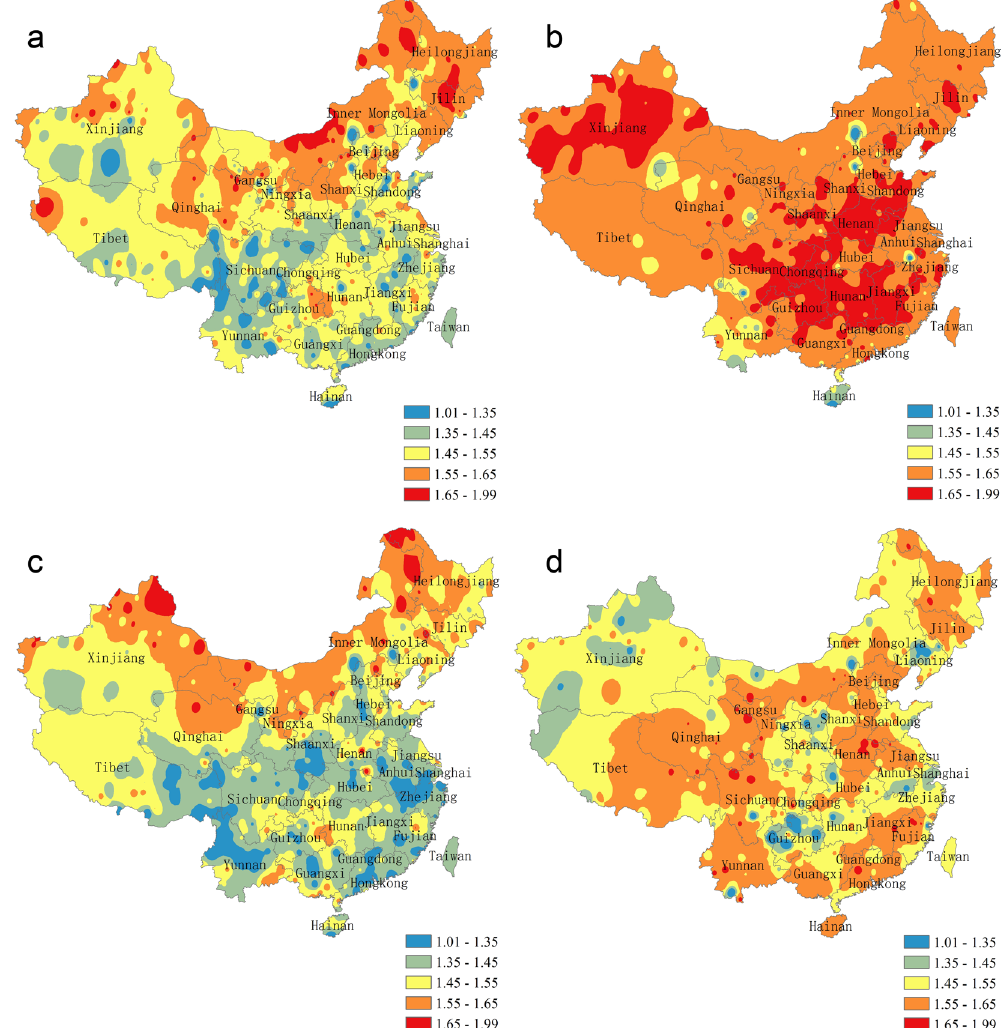
Figure 2. Variability of four climatic factors dynamics in China from 1960 to 2013: ( a ) ET0, ( b ) temperature, ( c ) solar radiation, ( d ) precipitation. The legend indicates value of fractal dimension which is used to depict variability, higher fractal dimension indicates higher variability. The map was generated by the software ArcGIS 10 81 .